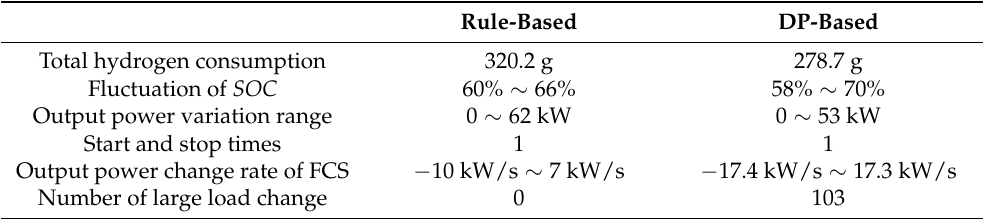
Table 2. Performance comparison between rule- and DP-based